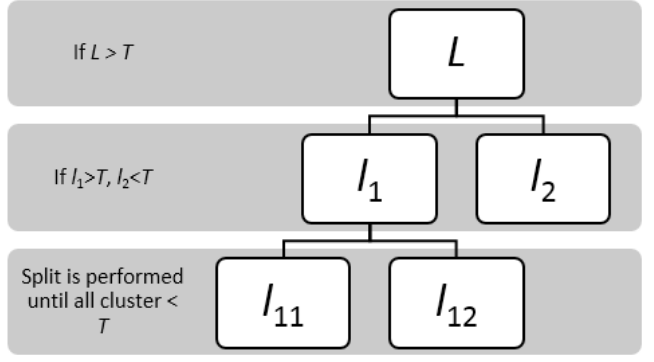
Figure 1. Example of clustering-based heuristics.